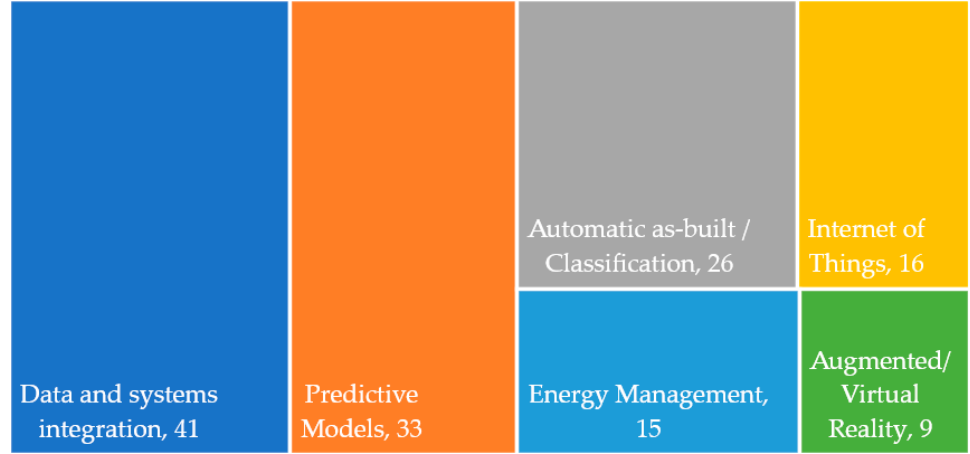
Figure 5. The current occurring keywords map per year.